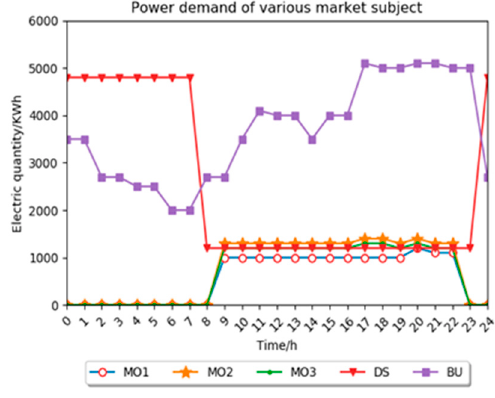
Figure 8. Electricity demand of various market players.